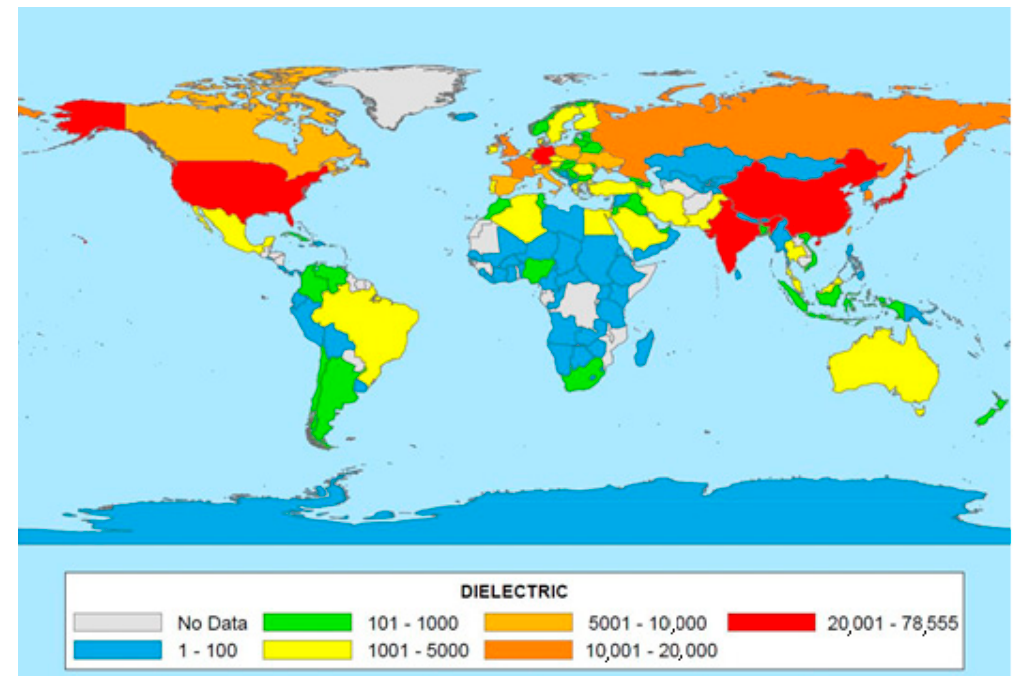
Figure 3. Map with worldwide distribution of dielectric publications.